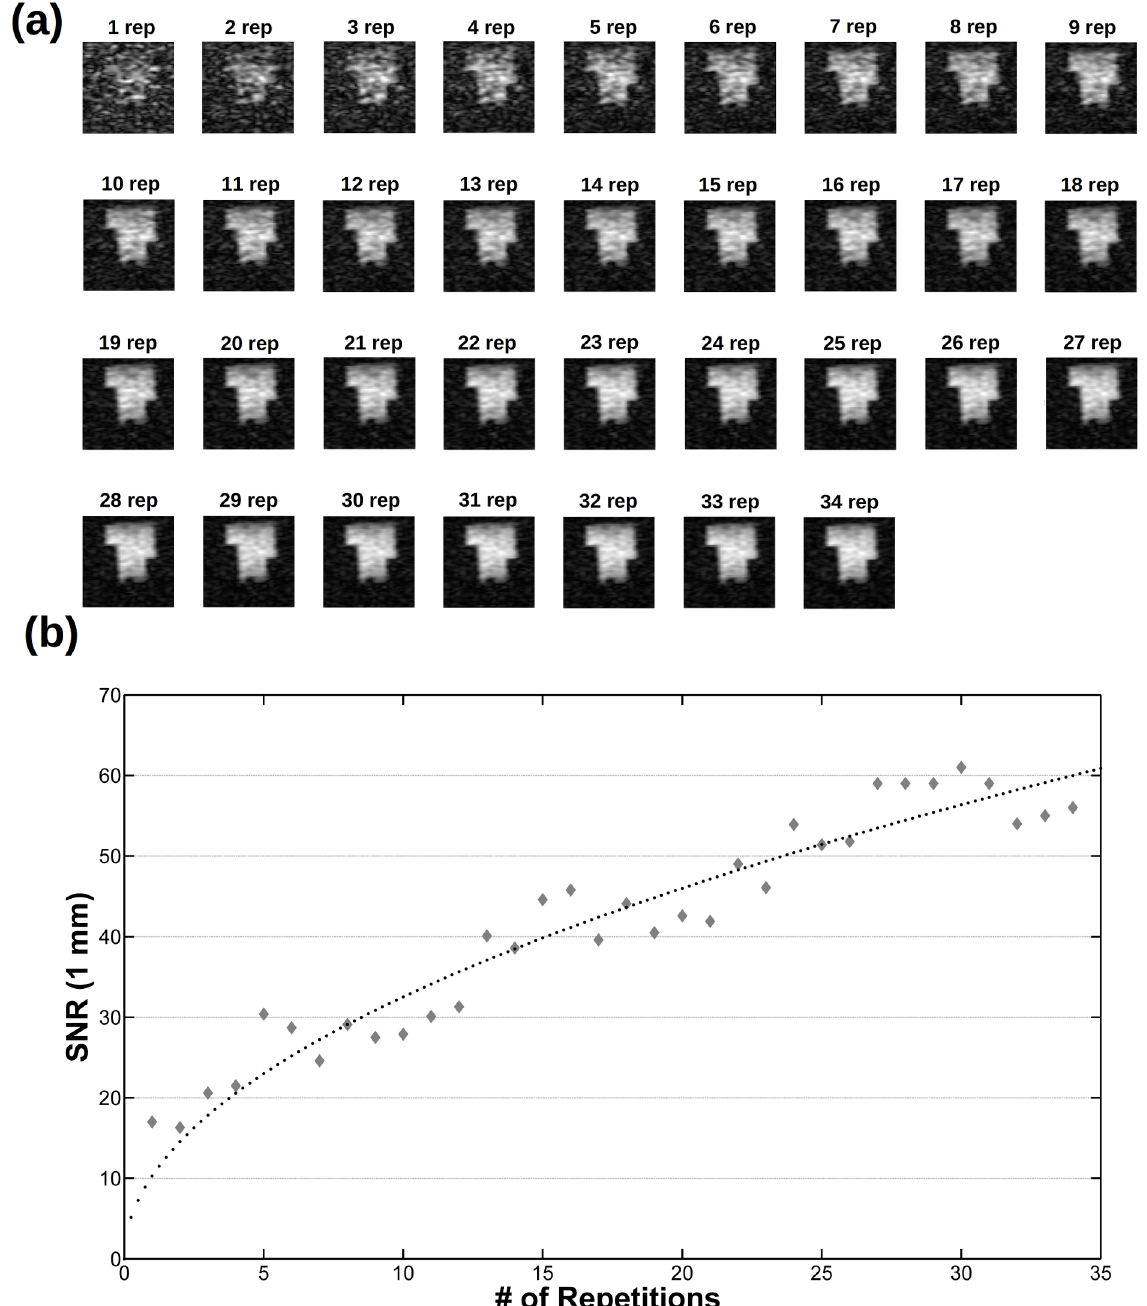
Fig 9. The same slice from a 643 3D phantom acquisition at 1x1x1 mm3 spatial resolution (spin echo, TE = 19 ms, TR = 500 ms, 32x32 phase encoding steps with zero filling to get a 643 matrix data, Tacq = 8.5 min for NEX = 1) at (a) different NEX values and (b) the corresponding SNR ffiffiffiffiffiffiffiffiffiffi p NEX fi t (dotted line). Although a longer acquisition time is needed, images with a resolution of 1 mm 3 can be recorded together with the related const (cid:4) with the VLF-MRI